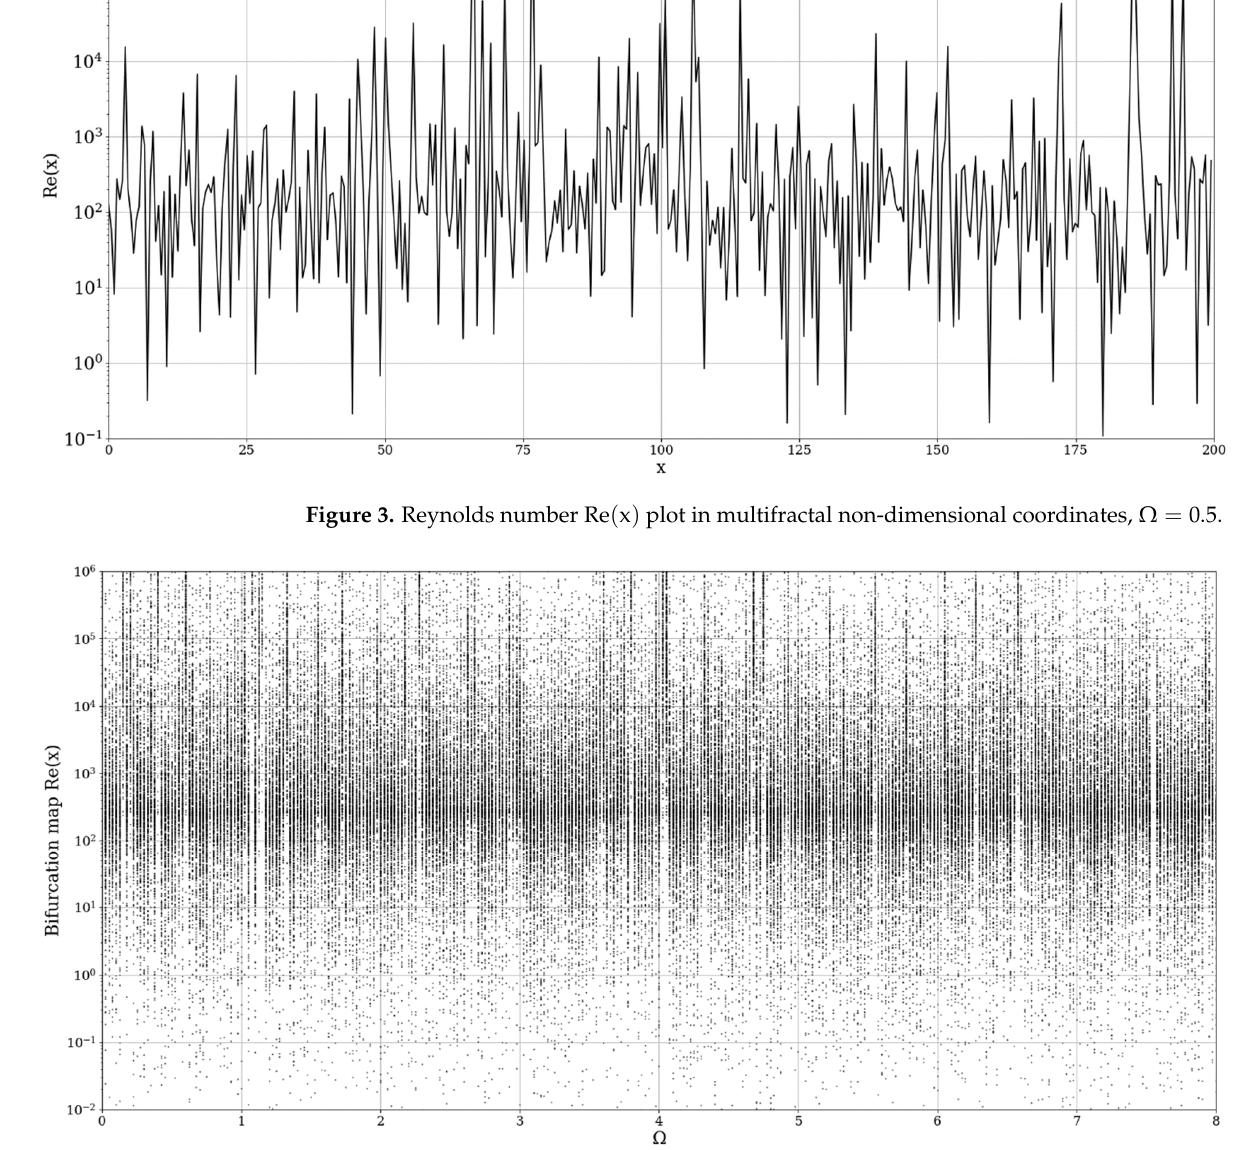
Figure 4. Bifurcation map of Reynolds number Re(x) ; control parameter: Ω .